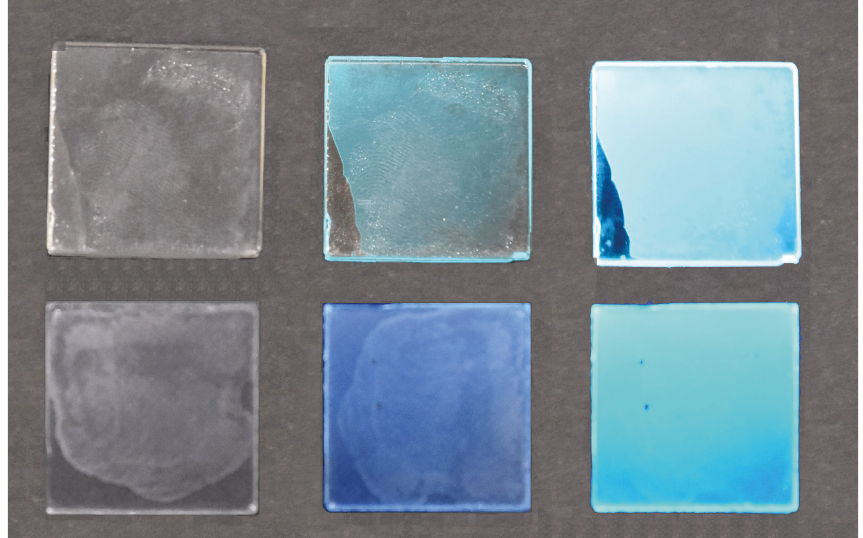
Figure 5: LC blends of NPh2 (above) and NPh5 (below) photographed in natural light (colourless, first column) and under a Wood’s lamp natural light on (second column) and off (third